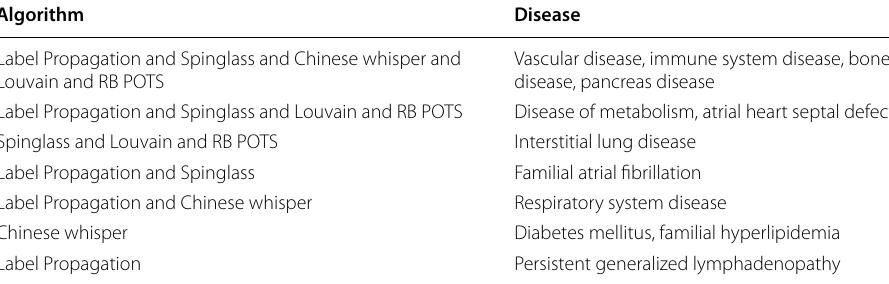
There are various lists of the same disease found in different algorithms